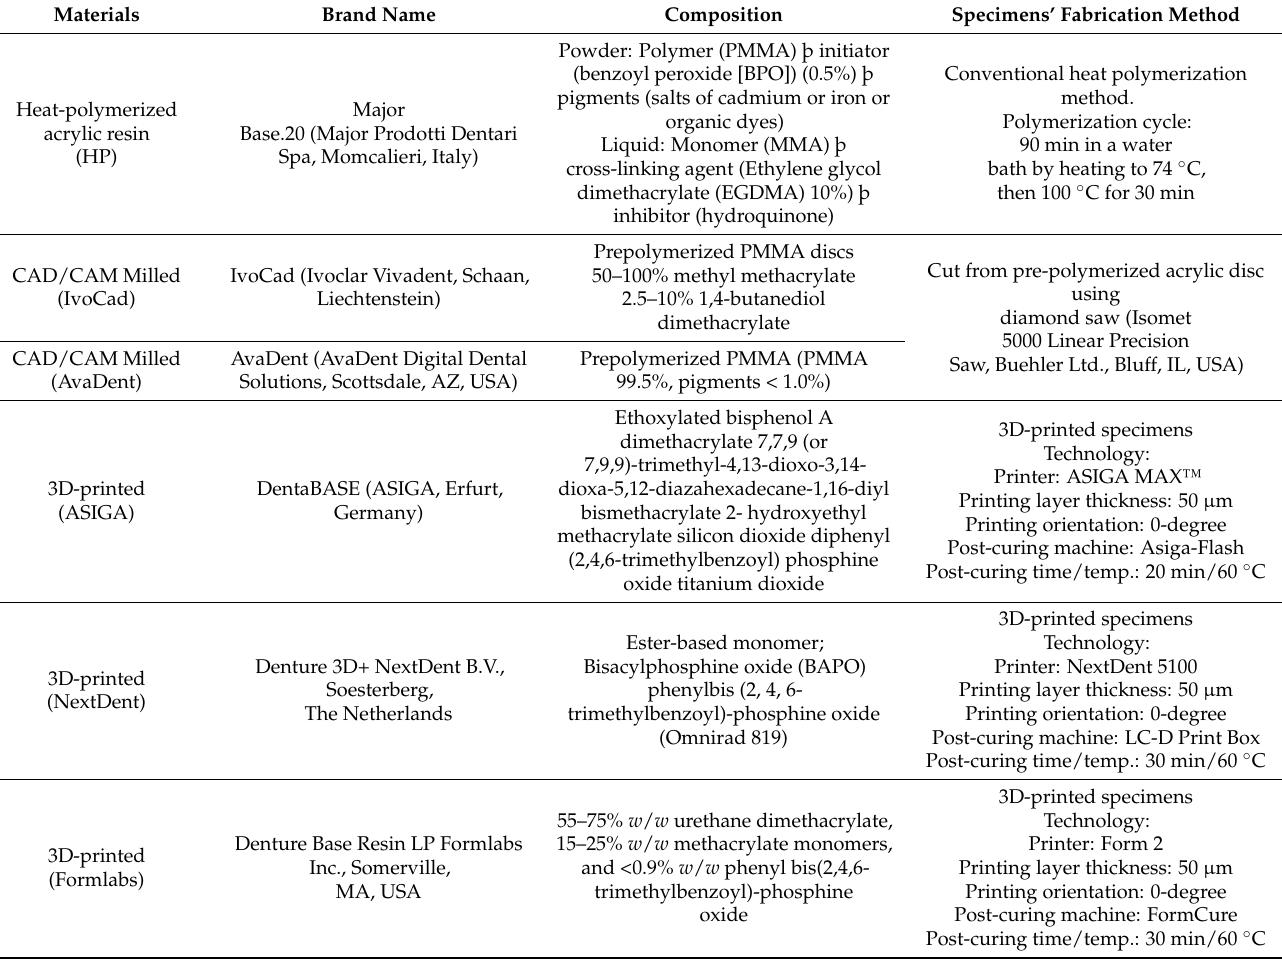
Table 1. Summary of materials used in present study and fabrication